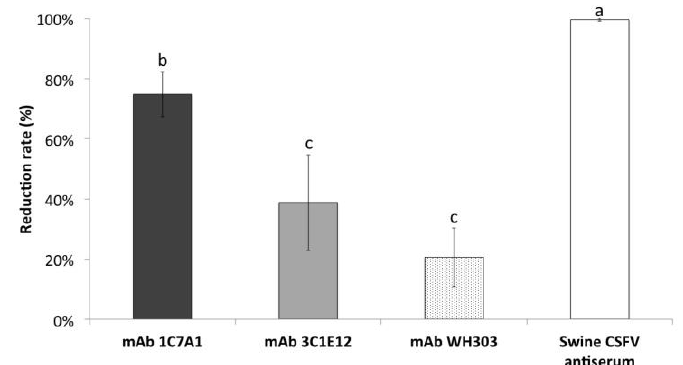
Figure 2. Inhibition of CSFV binding to porcine cells by three mAbs specific for glycoprotein E2 and polyclonal CSFV antiserum. An equal amount of each mAb was used (10 µg). The data represent the mean and standard deviation of three independent experiments. Values with different superscript letters, a – c, indicate a statistically significant difference ( p < 0.05) from each other. The superscript letter “a” indicates the highest and “c” indicates the lowest reduction of binding to cells among the compared groups. No significant differences exist between values containing the same letter.